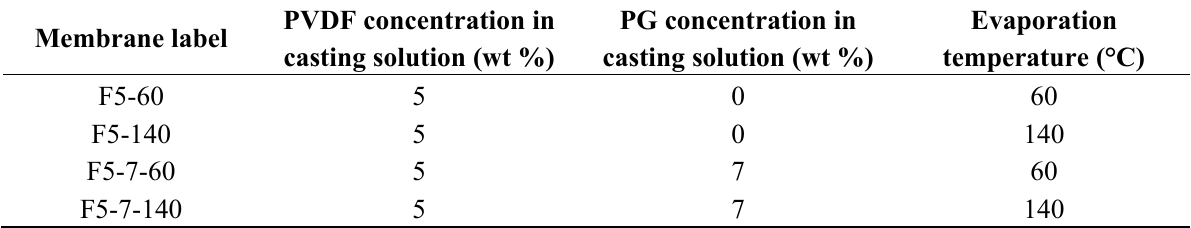
Table 1. Preparation conditions for solution-cast membranes. PVDF concentration in Membrane label casting solution (wt